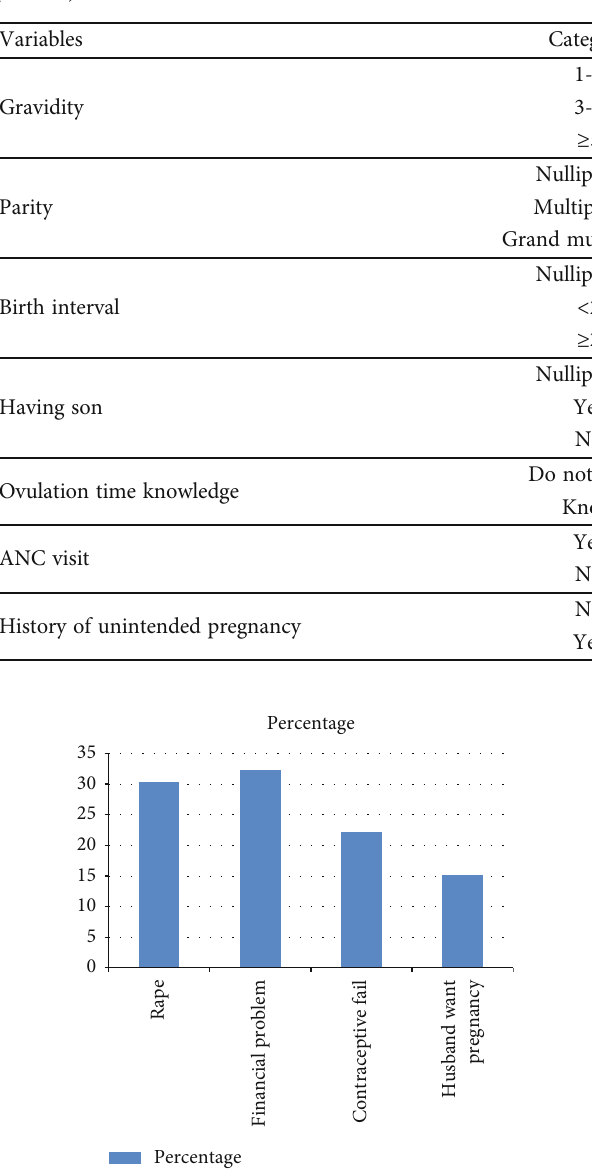
Table 2: Pregnancy and health-related characteristics of pregnant women living in Ilu Gelan district, West Shewa Zone, Ethiopia, 2021 ( n = 540 ).